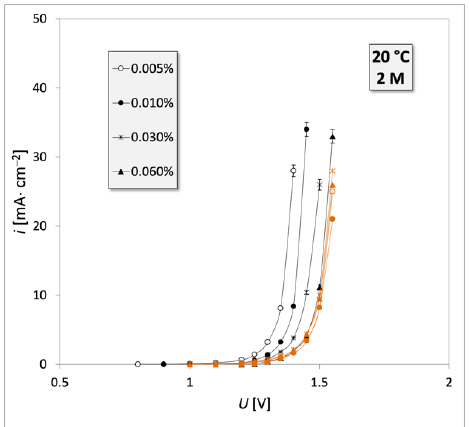
Energies 2021 , 14 , x FOR PEER REVIEW 7 of 11 Figure 5. Electro-oxidation curves of Syntanol DS-10 detergent (orange lines) and waste engine oil emulsion (black lines) at the temperature of 80 °C in a 0.5 M aqueous solution of H 2 SO 4 , for vari- ous concentrations of detergent and emulsion (0.005%, 0.010%, 0.030%, and 0.060% of reactor vol- ume).